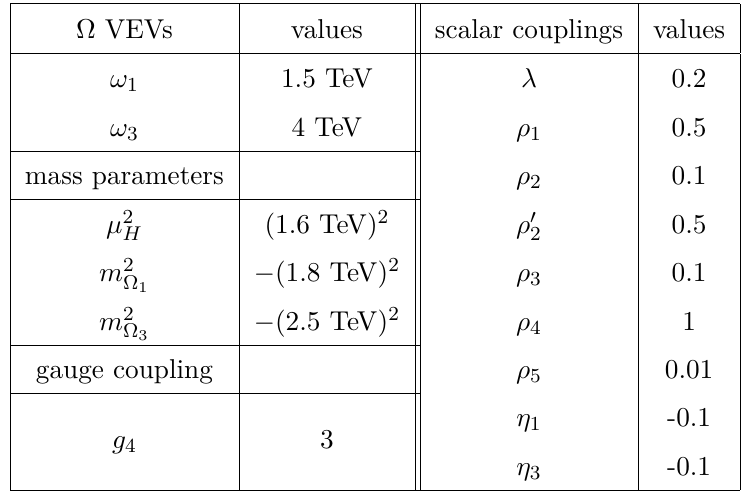
Table 2 . Benchmark for the boundary conditions of the model parameters at scale Λ 4